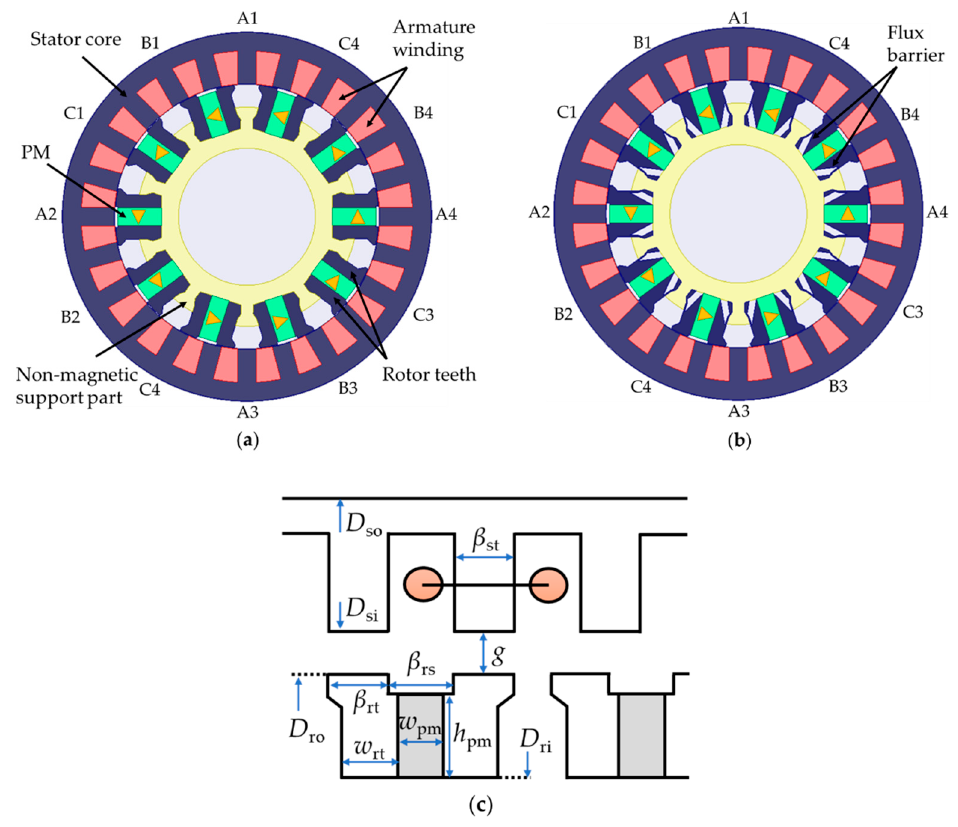
Figure 1. Topologies of the 24/10-pole RPM-FS machines. ( a ) Conventional structure. ( b ) Proposed structure. ( c ) Key design parameters.